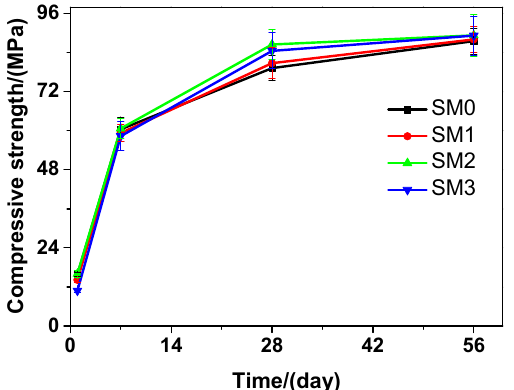
Figure 8. The compressive strength of siliceous sacrificial mortar at different curing